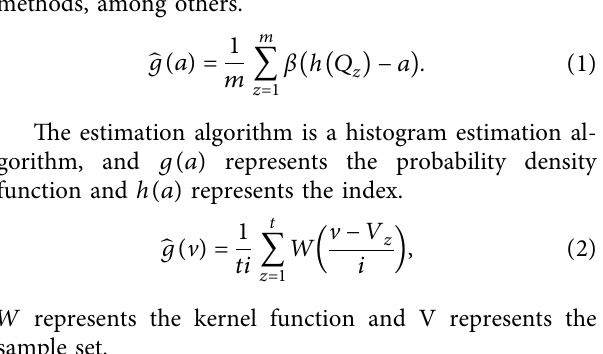
Figure 2: Data mining